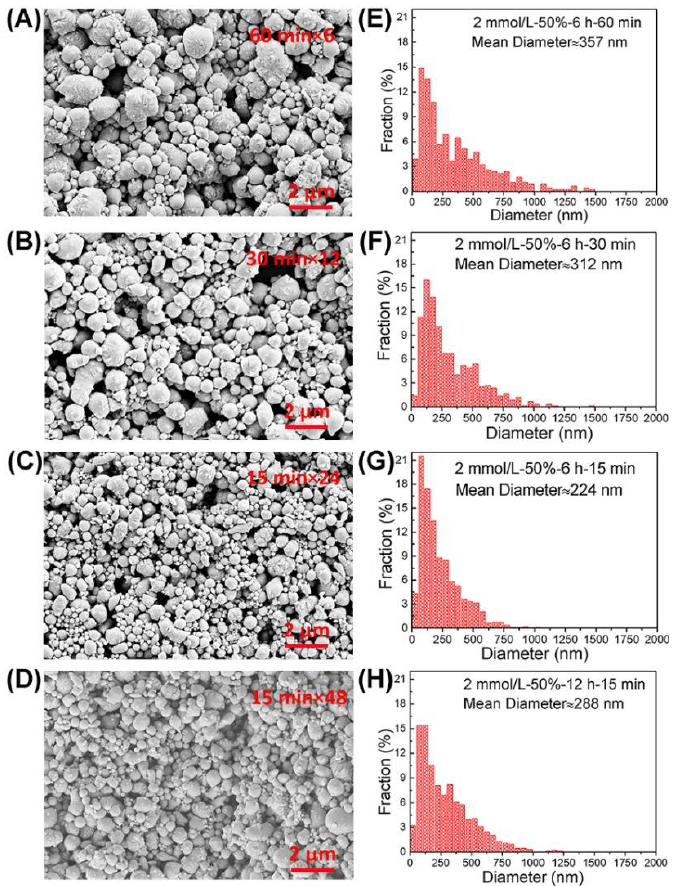
Figure 6. Morphology images and size distributions of eGaIn nanodroplets under different single ultrasonic durations: ( A , E ) 6 repeats of 60 min “on”, ( B , F ) 12 repeats of 30 min “on”, ( C , G ) 24 repeats of 15 min “on”, and ( D , H ) 48 repeats of 15 min “on”.